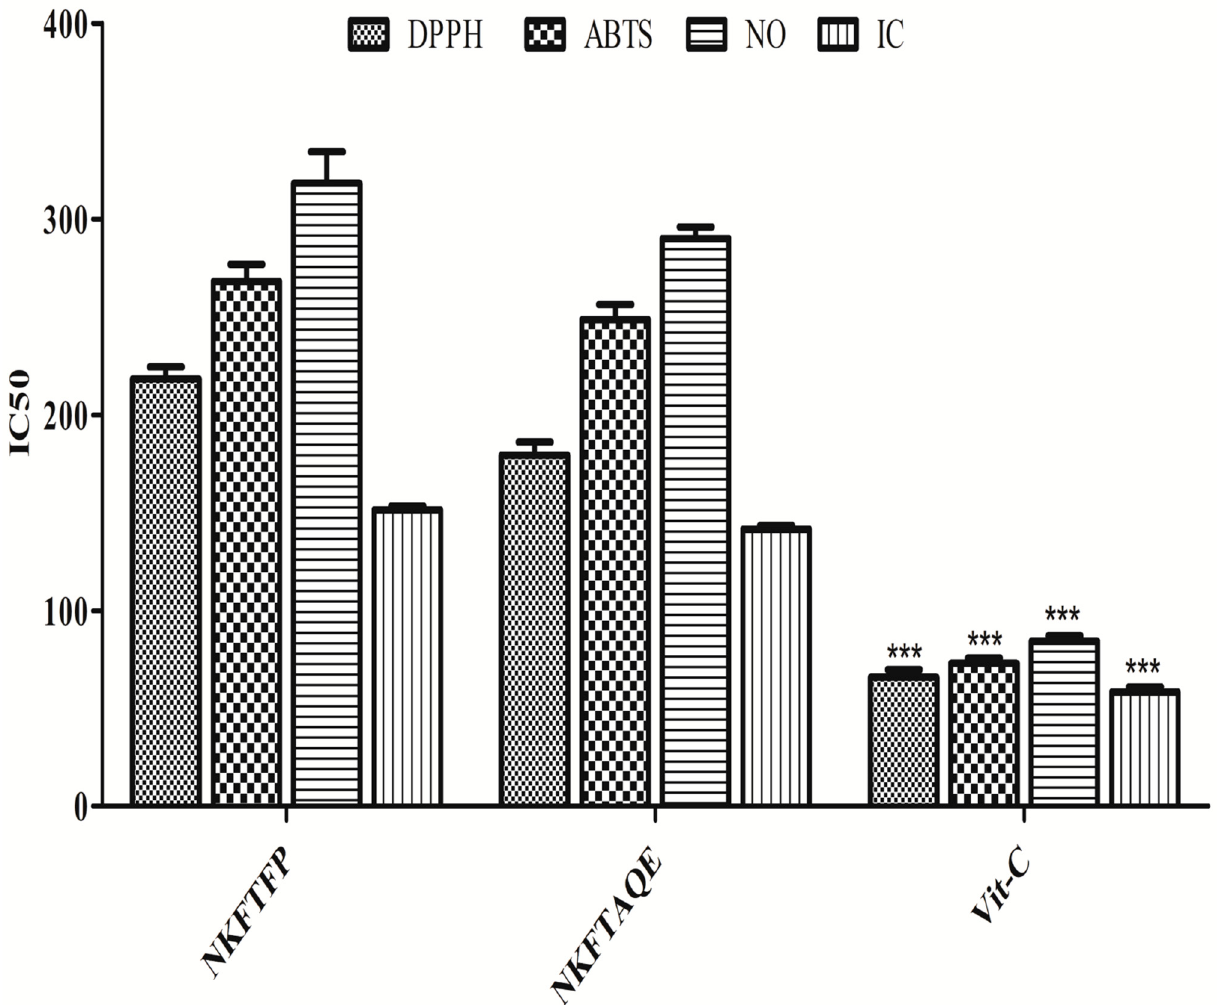
Figure 1. Free-radical scavenging capacity of NKFTFP and NKFTAQE. The statistical representation was made as mean ± SD ( n = 3). The comparisons are with respect to IC 50 for each sample. The statistical significance level is expressed at *** p < 0.001. The data represented by ‘***’ in Vit-C group showed significant variation in the activity then others.